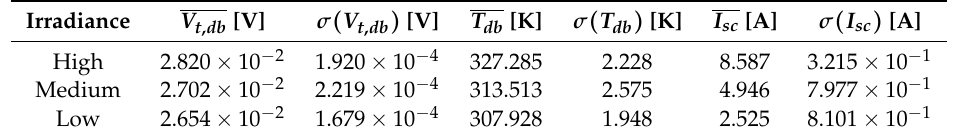
Table 10. Thermal voltage and temperature for bypass diode in submodule 2 and short-circuit current for high, medium and low irradiances from experimental data.